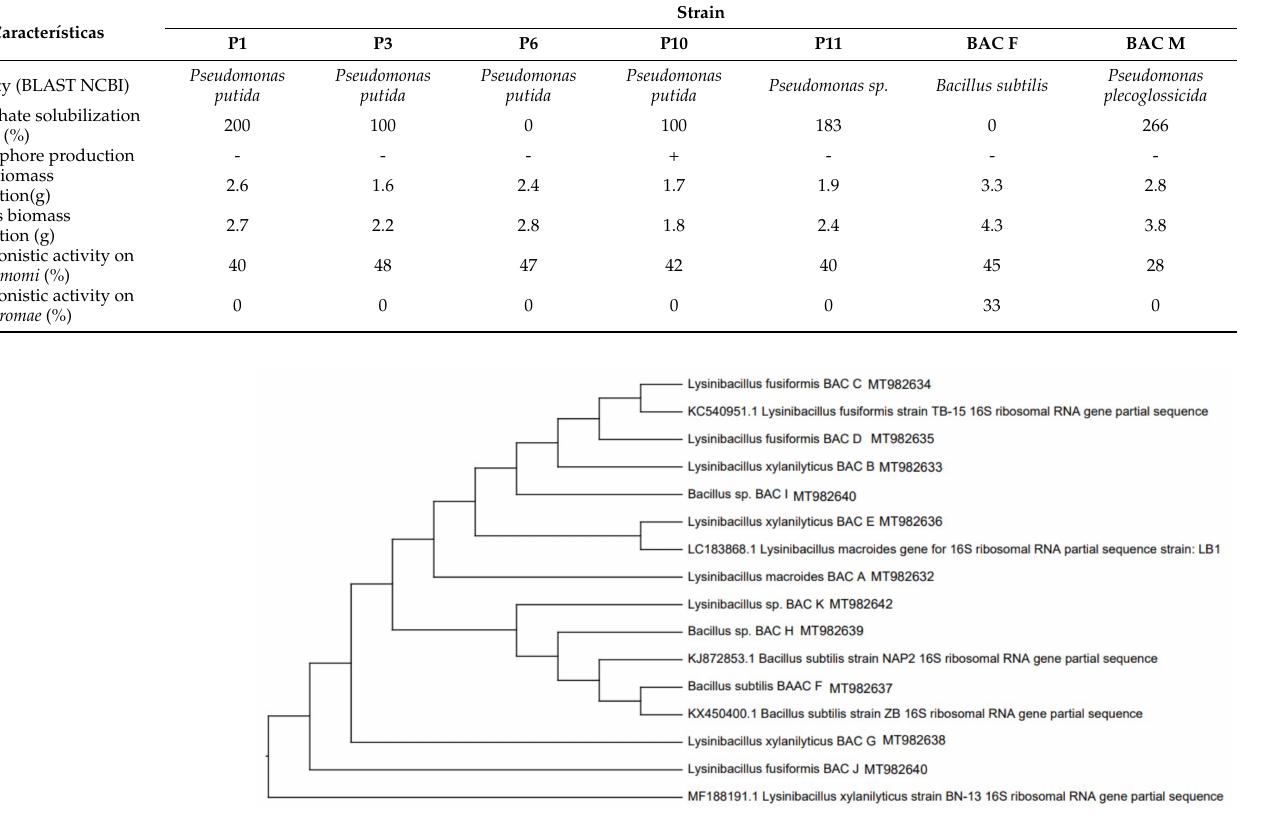
Figure 1. Phylogenetic tree constructed according to the maximum likelihood method based on the relationship between the 16S rRNA gene sequences of Bacillus strains isolated from the rhizosphere of P. americana and related Bacillus species. Sequences of the 16S rRNA gene of the Bacillus subtilis strain were arbitrarily chosen as a sequence outside the group.